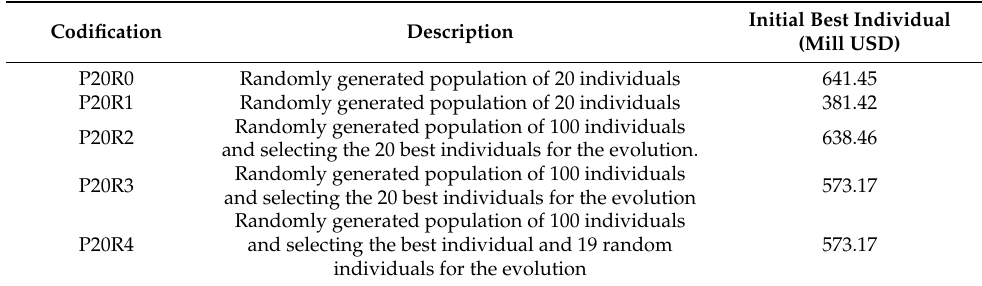
Table 10. Sensitivity analysis on the initial population.